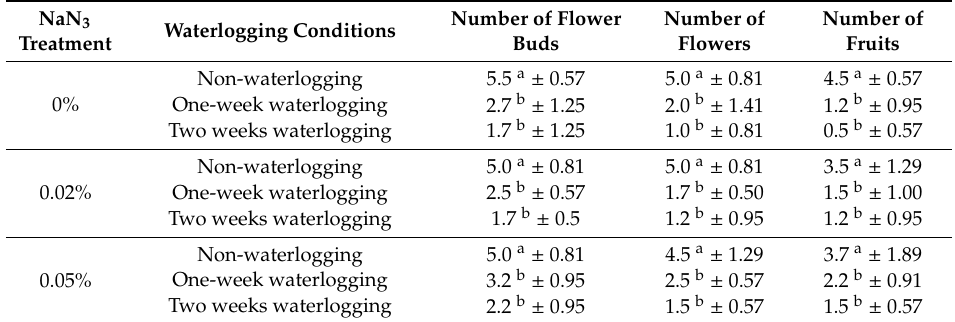
Table 4. Average number of flower buds, flowers, and fruits formed per plant of okra grown from NaN3 treated seeds subjected to waterlogging conditions ten weeks after